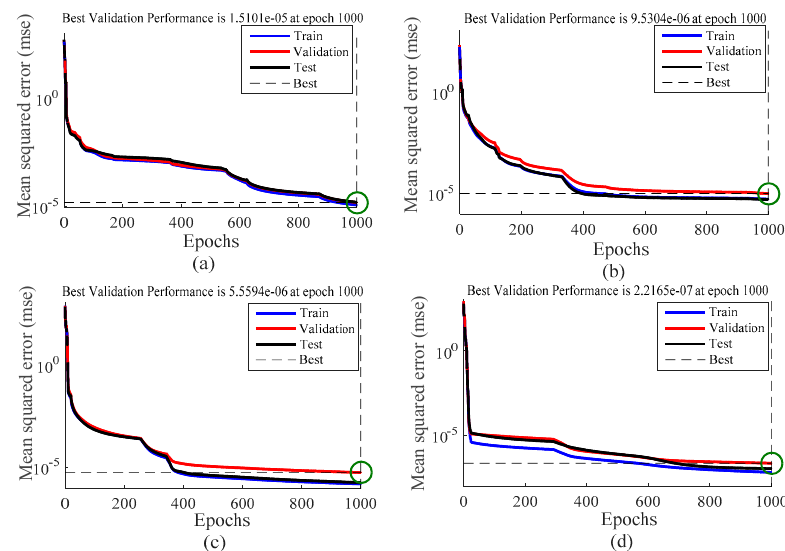
Figure 7. Performance of MSE of training, testing, and validation data for the LOS environments for ( a ) 5, ( b ) 10, ( c ) 15, and ( d ) 20 neurons.